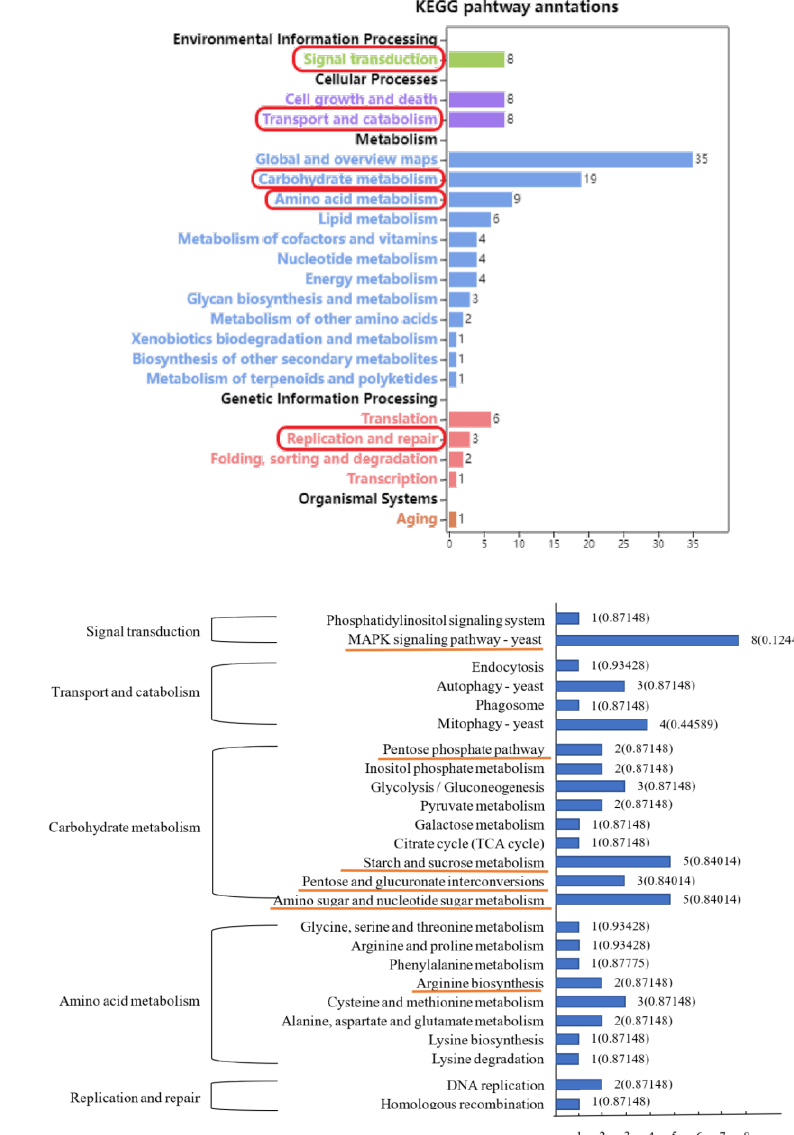
Figure 3. KEGG enrichment analysis of DEGs ( A ) and KEGG secondary subclass corresponding pathway of DEGs ( B ) in P. expansum . The red circle in ( A ) and the yellow underline in ( B ) marked are KEGG secondary term and pathways related to infection.